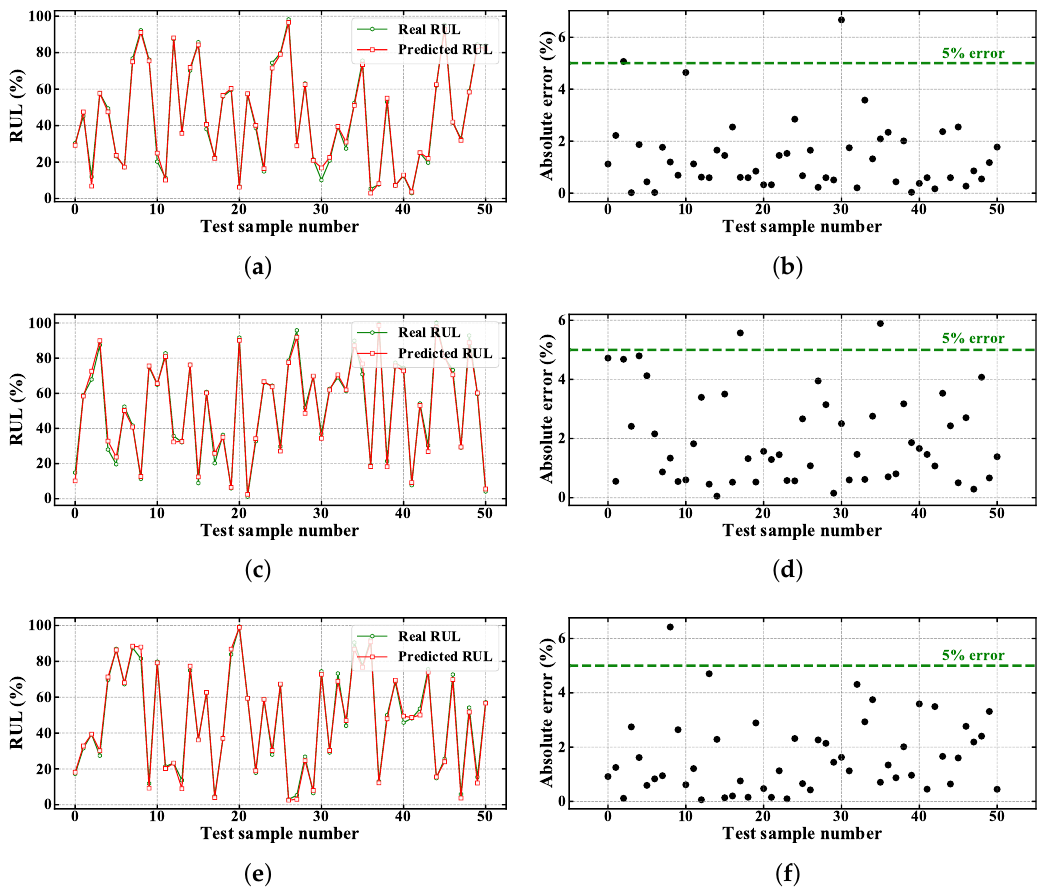
Figure 8. Results of experimental case 1. RUL prediction results and absolute errors when testing the PSO-GBDT method on single battery data: ( a , b ) Battery #5. ( c , d ) Battery #6. ( e , f ) Battery #7.